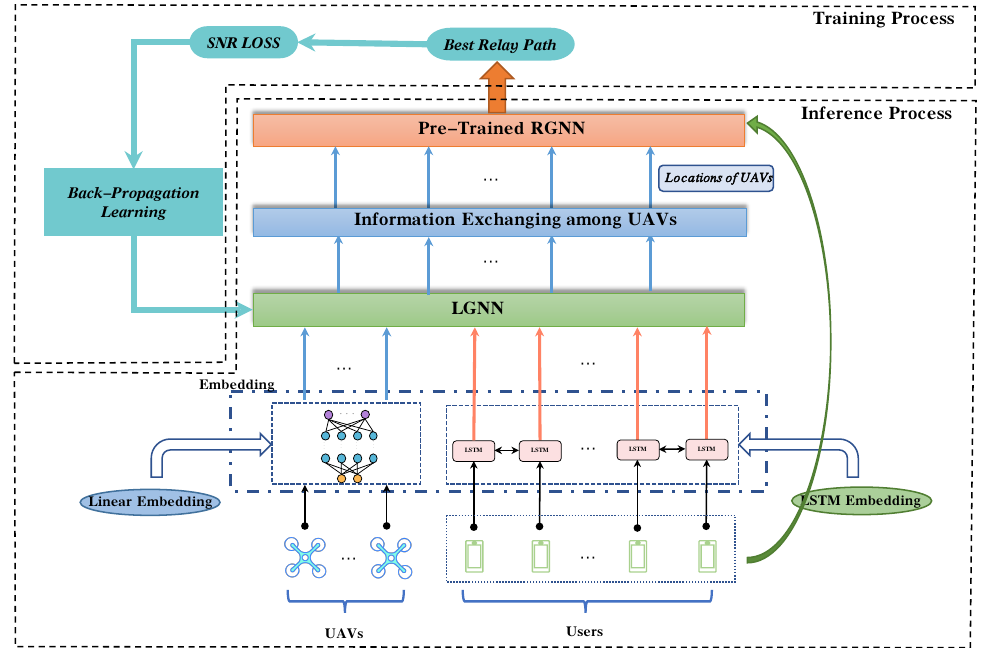
Figure 2. The structure of GNN driven relay and UAV location optimization method. In the training process, we first train an RGNN to optimize the relay path. Then we train the LGNN based on the relay path selected by RGNN. In the inference process, we optimize the location of the UAVs with LGNN first, then we use RGNN to select the best relay path for each pair of